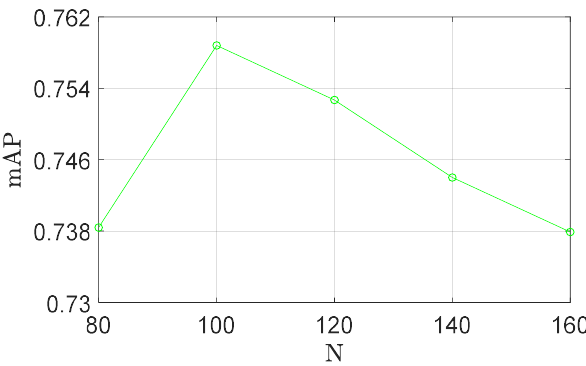
N on the detection accuracy.